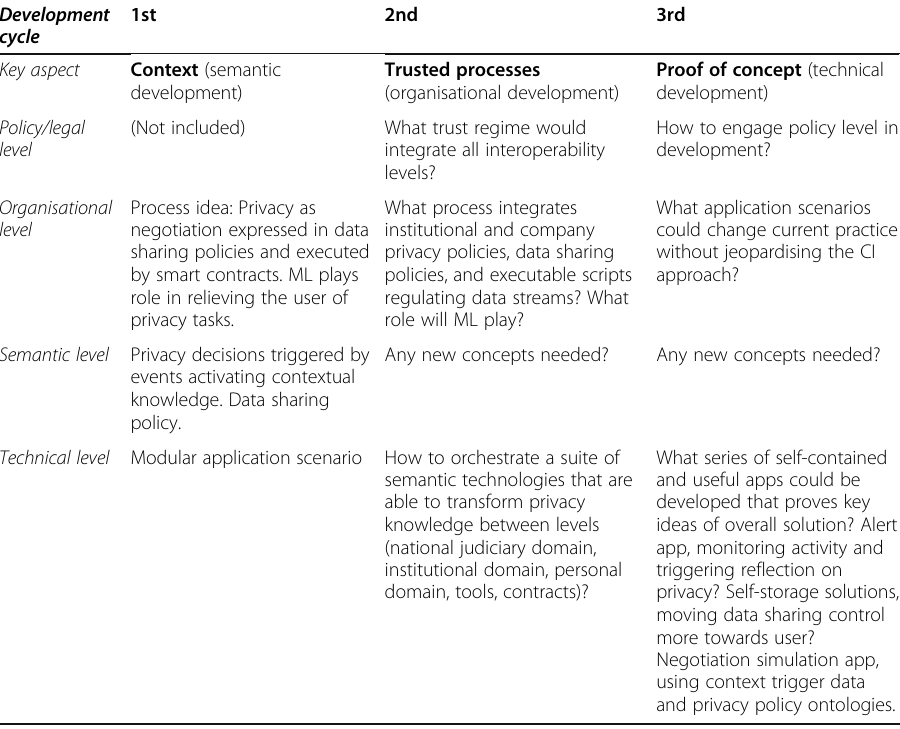
Table 2 Framework for privacy design, development cycles and levels Development